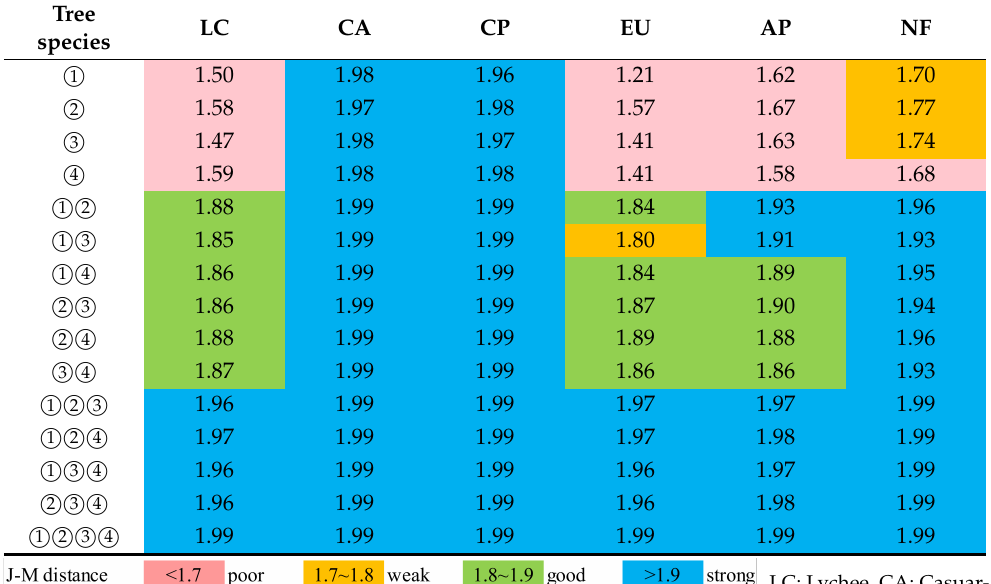
Table 2. Class separability between rubber trees and other tree species based on J m distance. Tree LC species